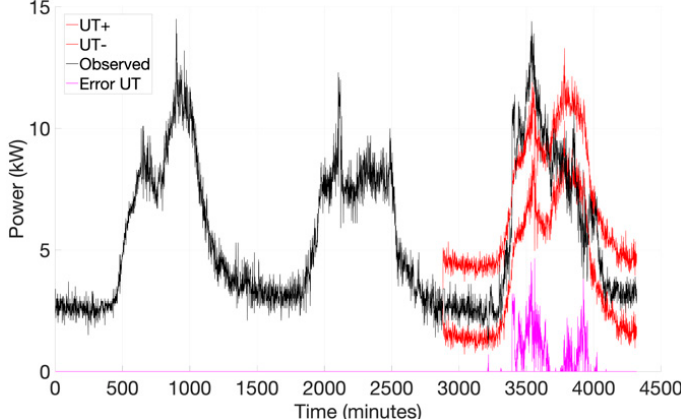
Figure 9. UT applied on demand house 1 plus error.